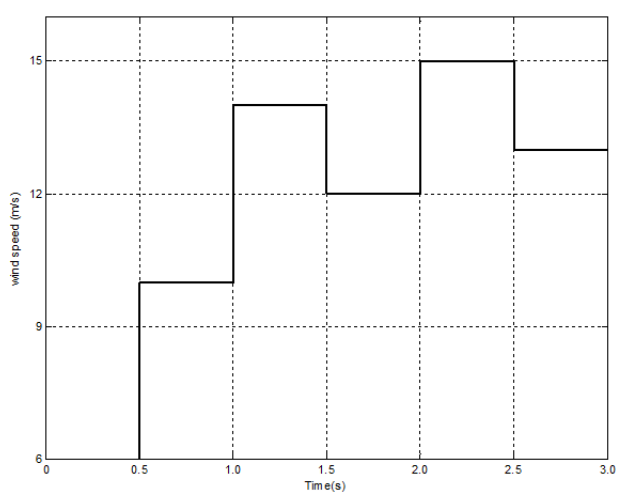
Energies 2016 , 9 , 793